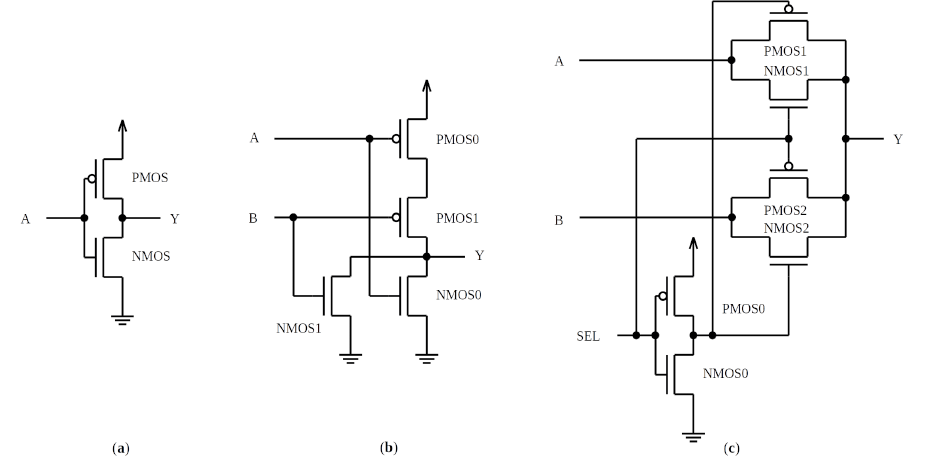
Figure 4. Adopted topologies for the internal logic gates of the Versatile CLB—( a ) Inverter; ( b ) 2-Input NOR; and ( c ) 2-Input